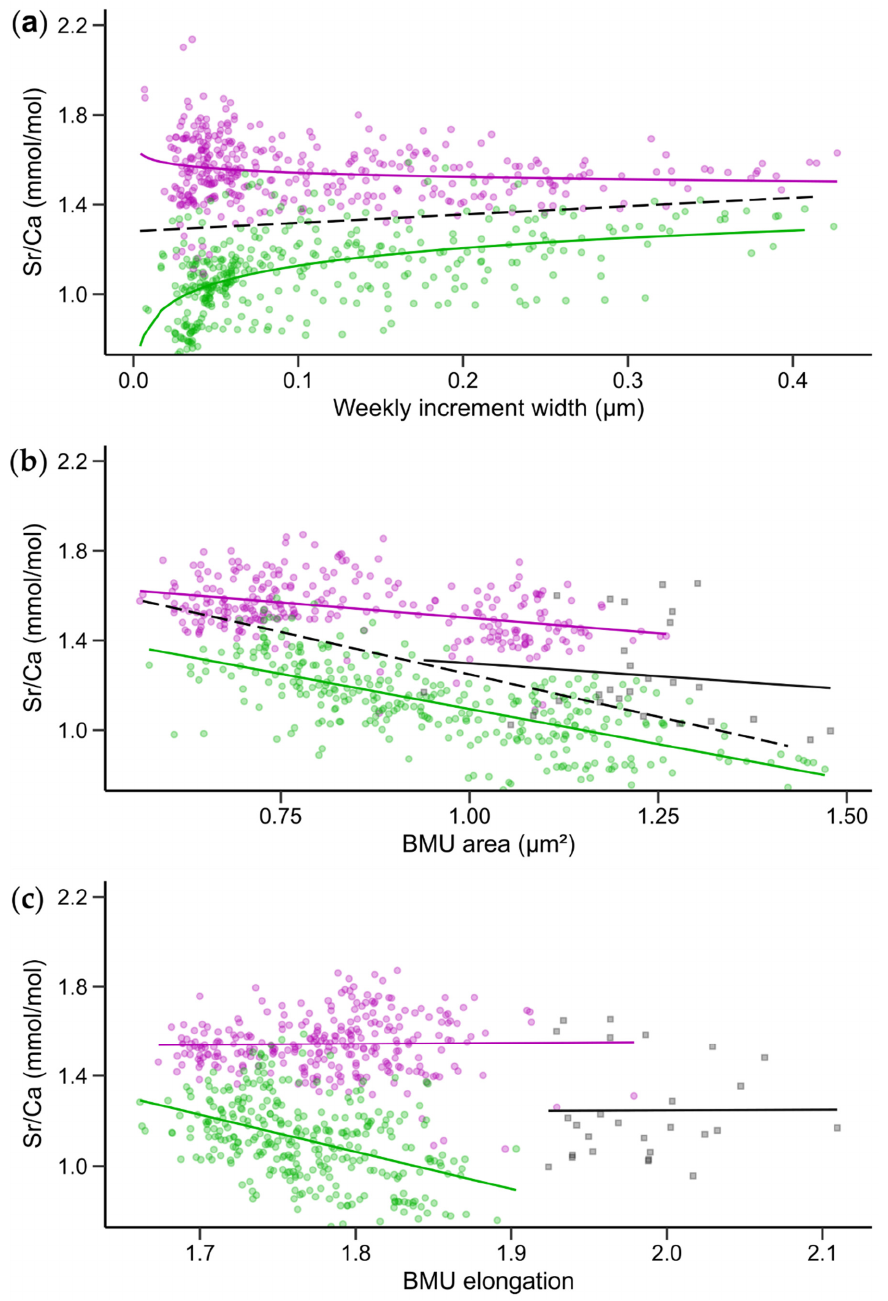
Figure 6. Relationships between Sr/Ca data and microstructural properties of Arctica islandica shells. Acronyms and color coding as in caption of Figure 3. BMU = biomineral unit. Note, magenta = homogenous microstructure (oOSL); green = crossed-acicular microstructure (iOSL); black = hinge. Green and purple data are weekly resolved, black data monthly. Regression curves are depicted in same color as data of respective shell portion. Black dashed lines represent linear regression model of entire outer shell layer (oOSL + iOSL) dataset. ( a ) In the inner portion of the outer shell layer (iOSL, magenta), shell Sr/Ca is weakly negatively linked to increment width, whereas a stronger and positive correlation exists in the outer sublayer of outer shell layer (oOSL, green). Note that non-linear models provided a better fit than linear models. When data from both OSL sublayers (oOSL, iOSL) are combined, a weak positive correlation is found with shell growth rate. ( b ) Shell Sr/Ca is negatively correlated to BMU area. ( c ) In the oOSL and hinge, shell Sr/Ca is weekly positively coupled to BMU elongation, but a stronger and negative correlation exists in the